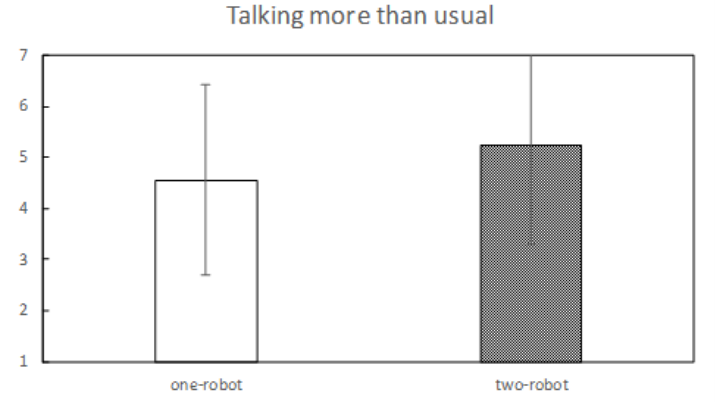
Figure 11. Averages of the scores of the question to the